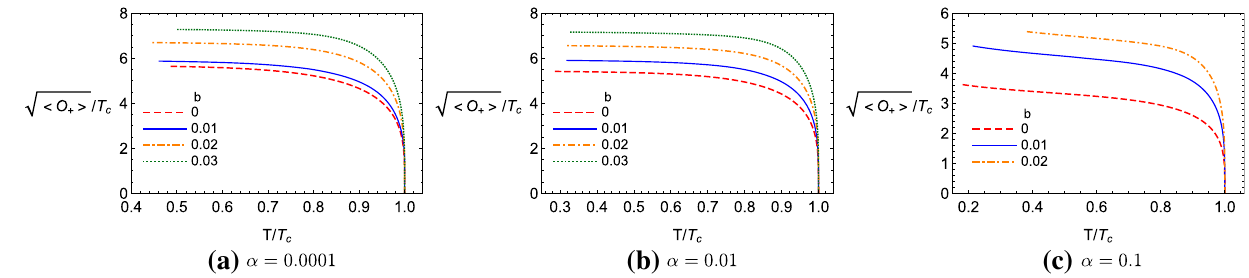
Fig. 2 The condensate operator < O + > as a function of the temperature for different values of b and various values of α , where we have set < O − > = 0 and ˜ m 2 = − 3